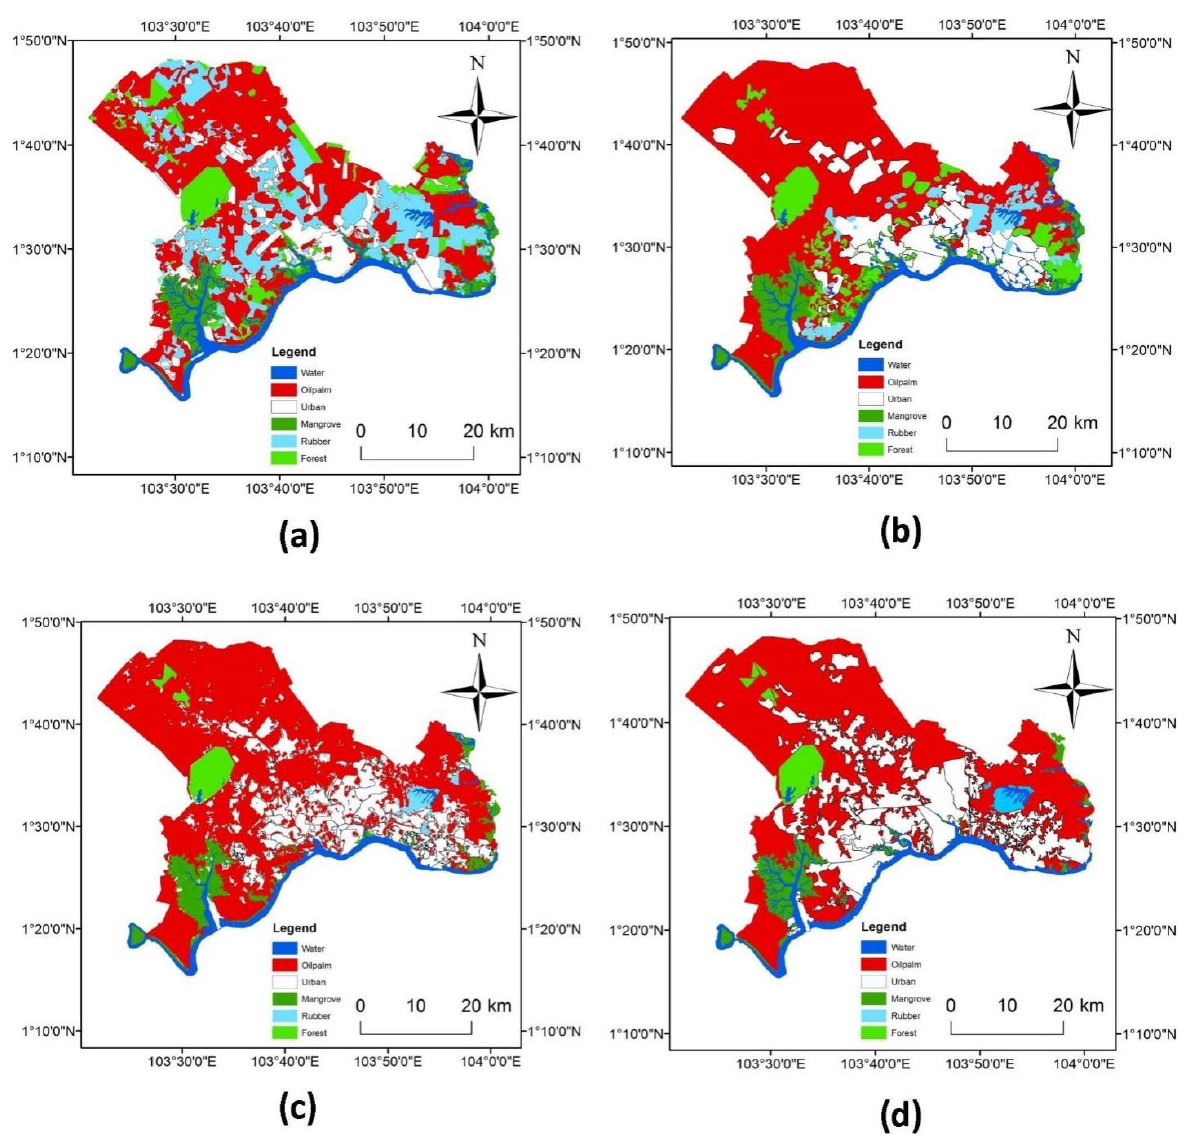
Figure 6. Land use/Land cover classification in Iskandar Malaysia ( a ) 1989; ( b ) 2000; ( c ) 2007; and ( d )